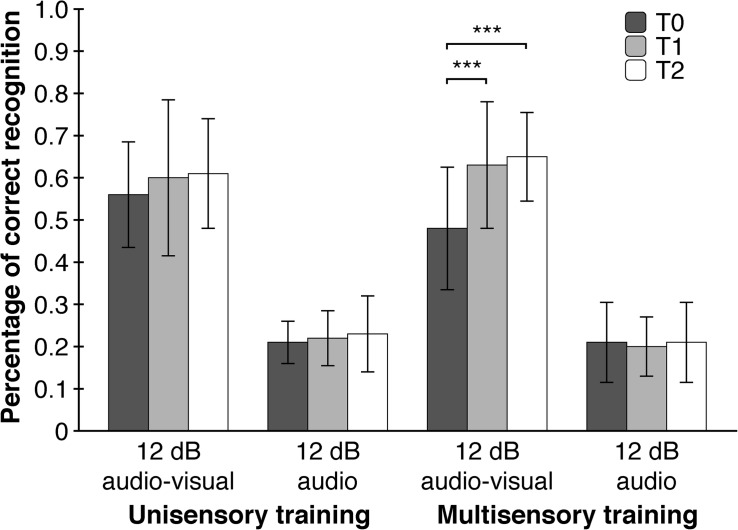
Multisensory trainings contribute to an increased performance in word recognition in situations with a low signal-to-noise ratio (12 dB audio-visual). Depicted are two of the four WRT conditions of interest. Error Bars indicate SDs. ∗∗∗p < 0.001.